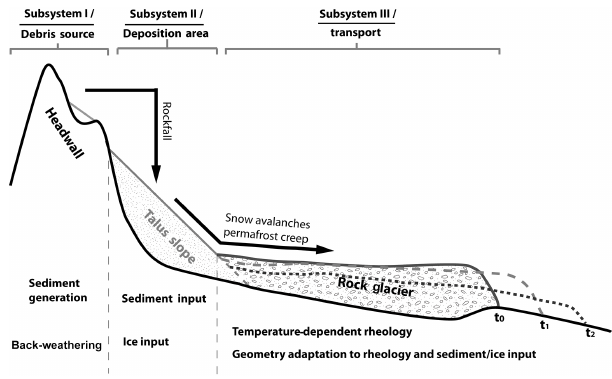
Figure 1. Conceptual model of the dynamic evolution of a rock glacier system (adapted from Fig. 1 in Müller et al., 2014a). Black arrows show the sediment transport. t 0 , t 1 and t 2 show the rock glacier surface geometries at different time steps resulting from variations in environmental factors such as warming and a decrease of sediment–ice